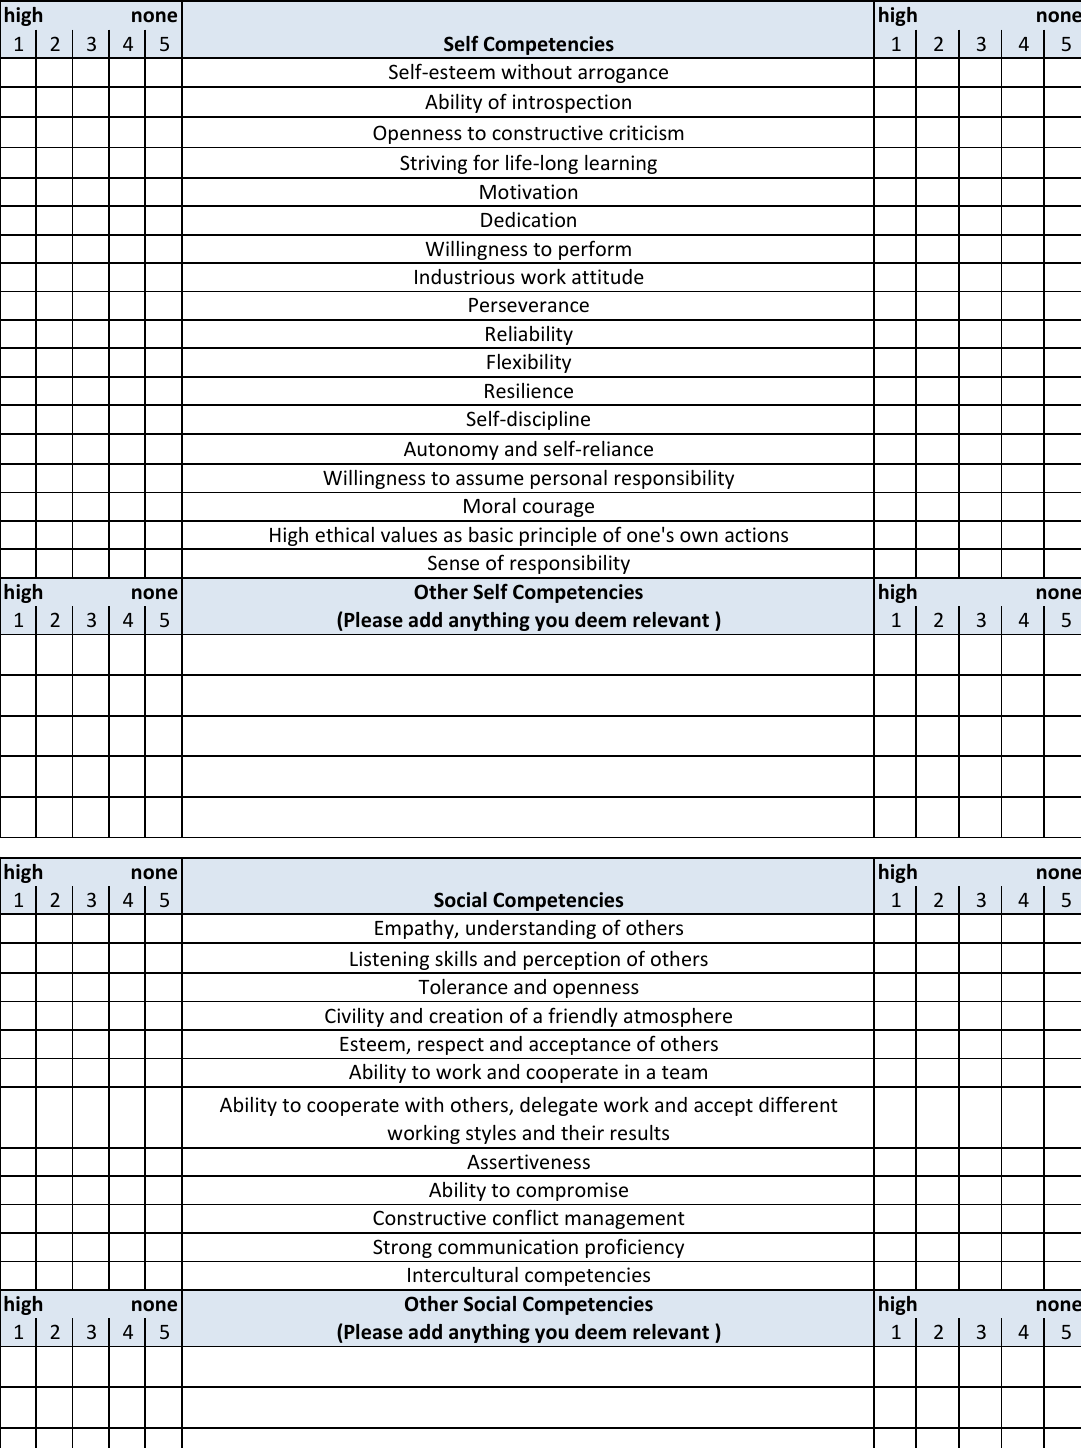
Figure 7. Second page of our questionnaire questionnaire for lecturers on the competencies of incoming first year students (translated from the German original)